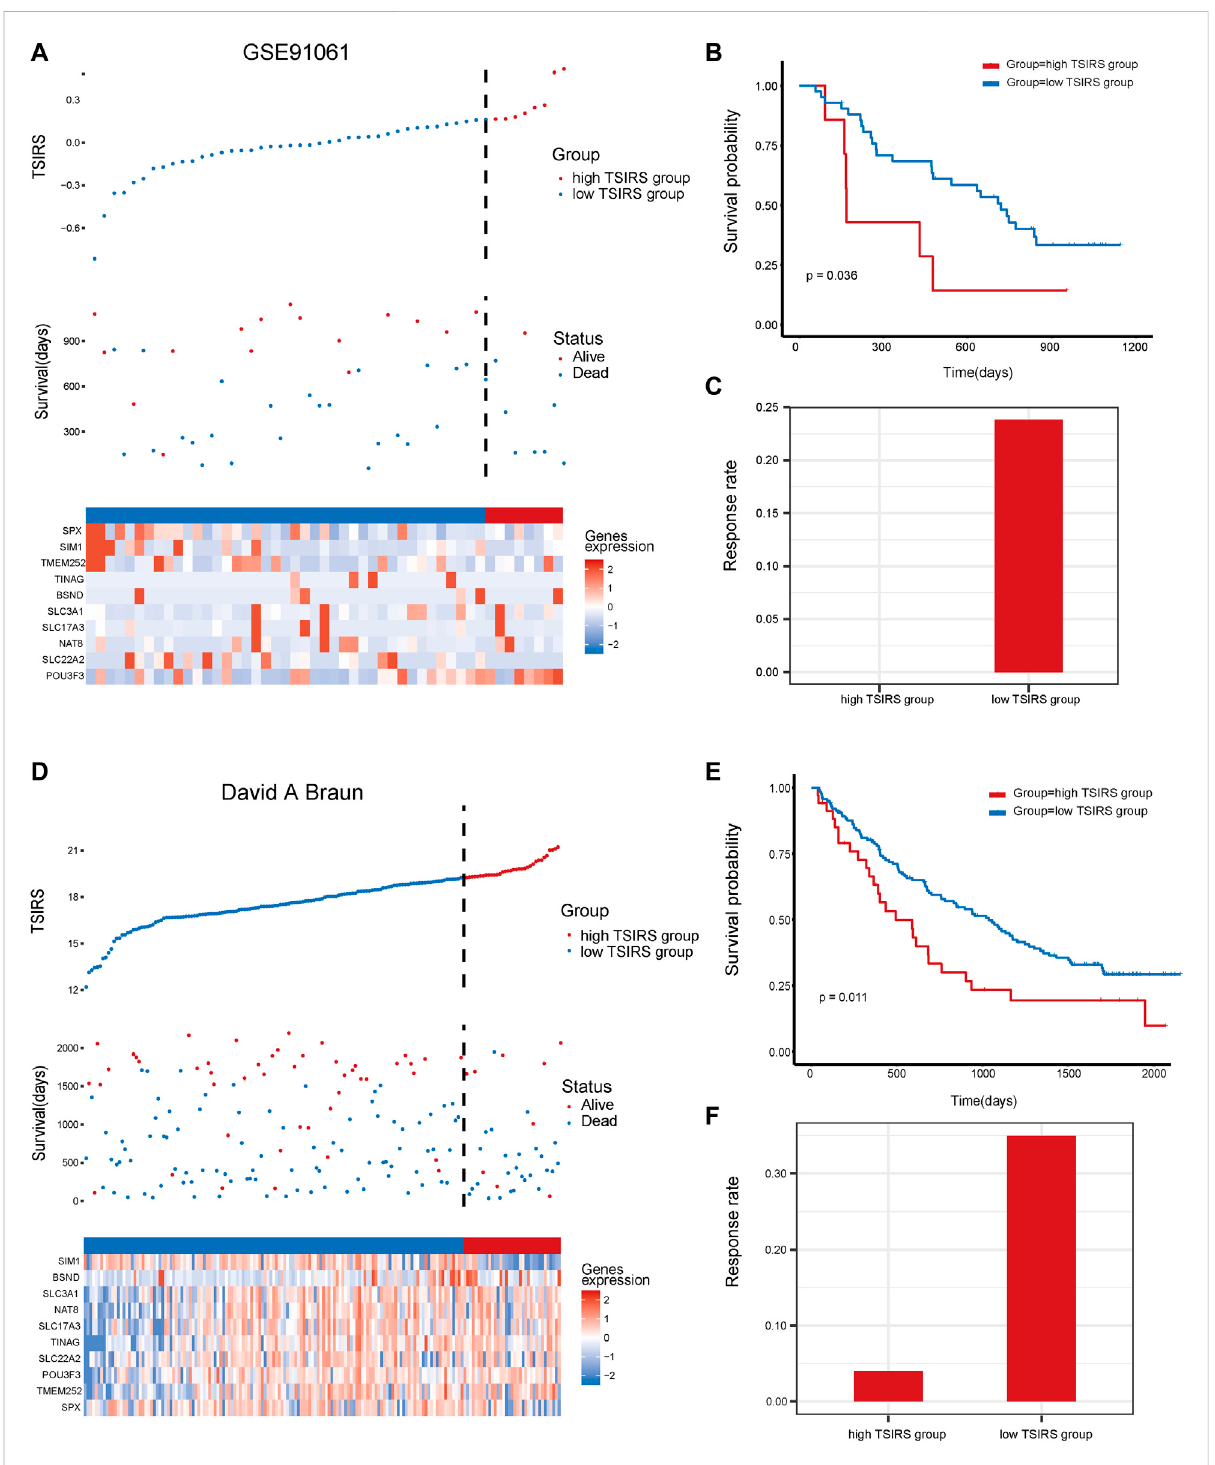
FIGURE 5 The prognosiseffectivenessof TSIRS in GSE91061 cohortand DavidA. Brauncohort. (A) Distribution of thehigh TSIRS group and the low TSIRS group in GSE91061 cohort. (B) Comparison of patient prognosis of the high TSIRS group and the low TSIRS group in GSE91061 cohort. (C) Patient therapy responsiveness rate of the high TSIRS group and the low TSIRS group in GSE91061 cohort. (D) Distribution of the high TSIRS group and the low TSIRS group in David A. Braun cohort. (E) Comparison of patient prognosis of the high TSIRS group and the low TSIRS group in David A. Braun cohort. (F) Patient therapy responsiveness rate of the high TSIRS group and the low TSIRS group in David A. Braun